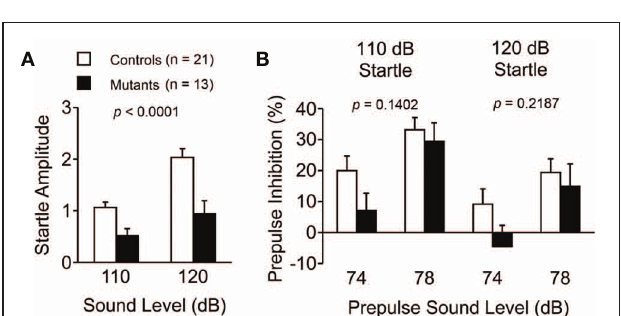
FIGURE 5 | Suppressed startle response and normal prepulse inhibition in Apc + / − mice 8–10 weeks of age. (A) Acoustic startle response for the 110 and 120dB startle stimulus was significantly suppressed in Apc + / − mice. (B) Apc + / − mice showed normal prepulse inhibition for the 74 and 78dB prepulse sound levels. Apc + / − mice, n = 13; wild-type mice, n = 21.